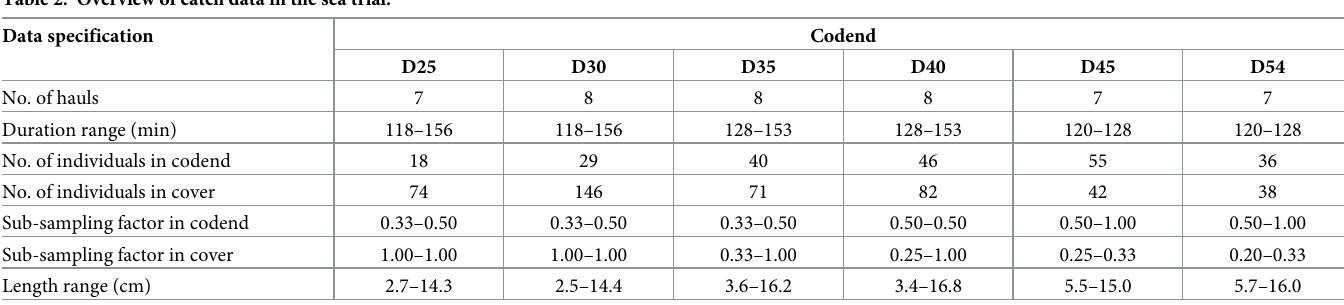
Table 2. Overview of catch data in the sea trial.